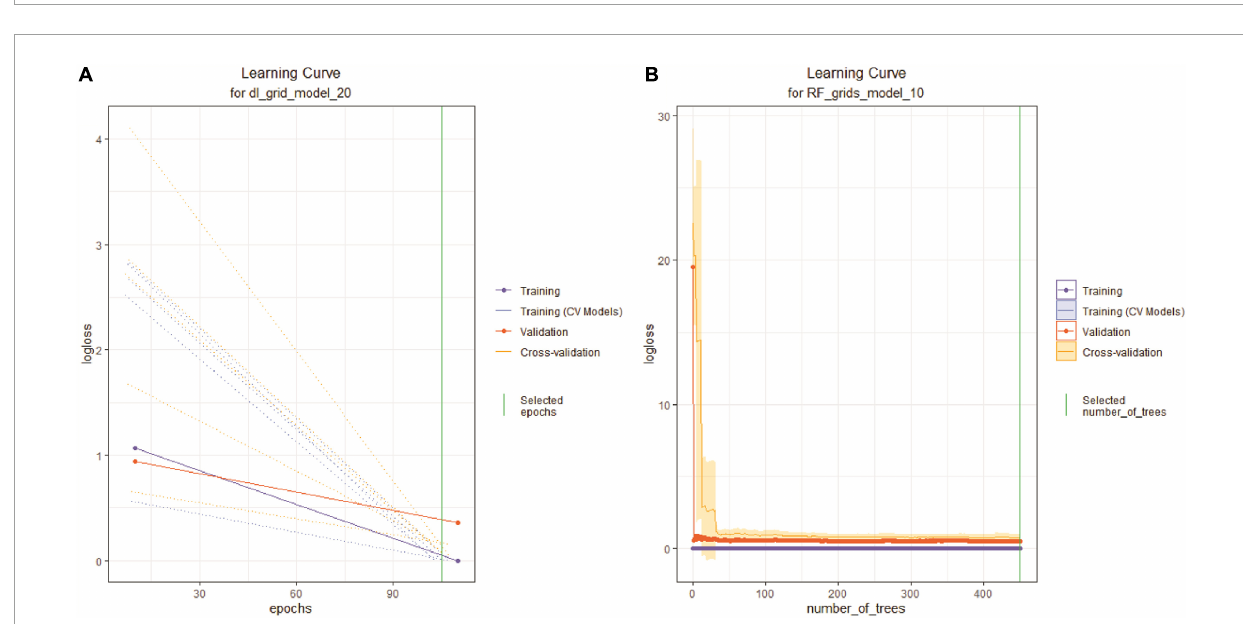
FIGURE8 Learning curve for diagnosing the fitness of the model for (A) DNN, and (B) RF